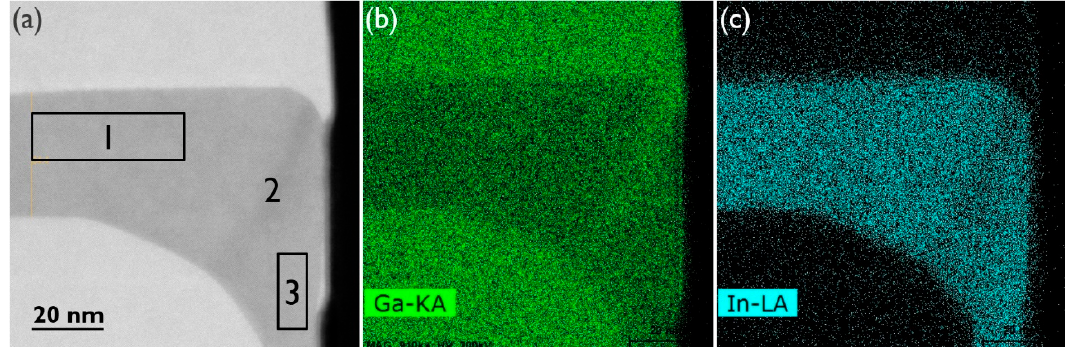
Figure 4. ( a ) HAADF-STEM image of an InGaP corner between 2 GaAs layers, and EDS maps of that corner based on ( b ) Ga-K α and ( c ) In-L α X-ray emission. The In composition of regions 1, 2 (the darker vein) and 3 is deduced as the following: 42%, 33% and 40%, respectively.